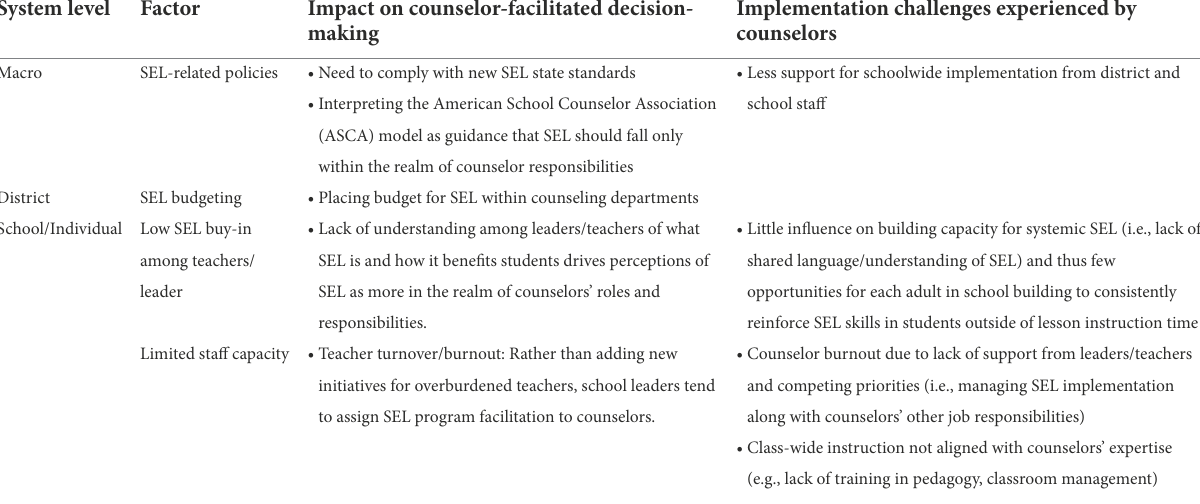
TABLE 4 Summary of Second Step staff interviews: Factors related to SEL program decision-making and implementation challenges experienced by counselors. System